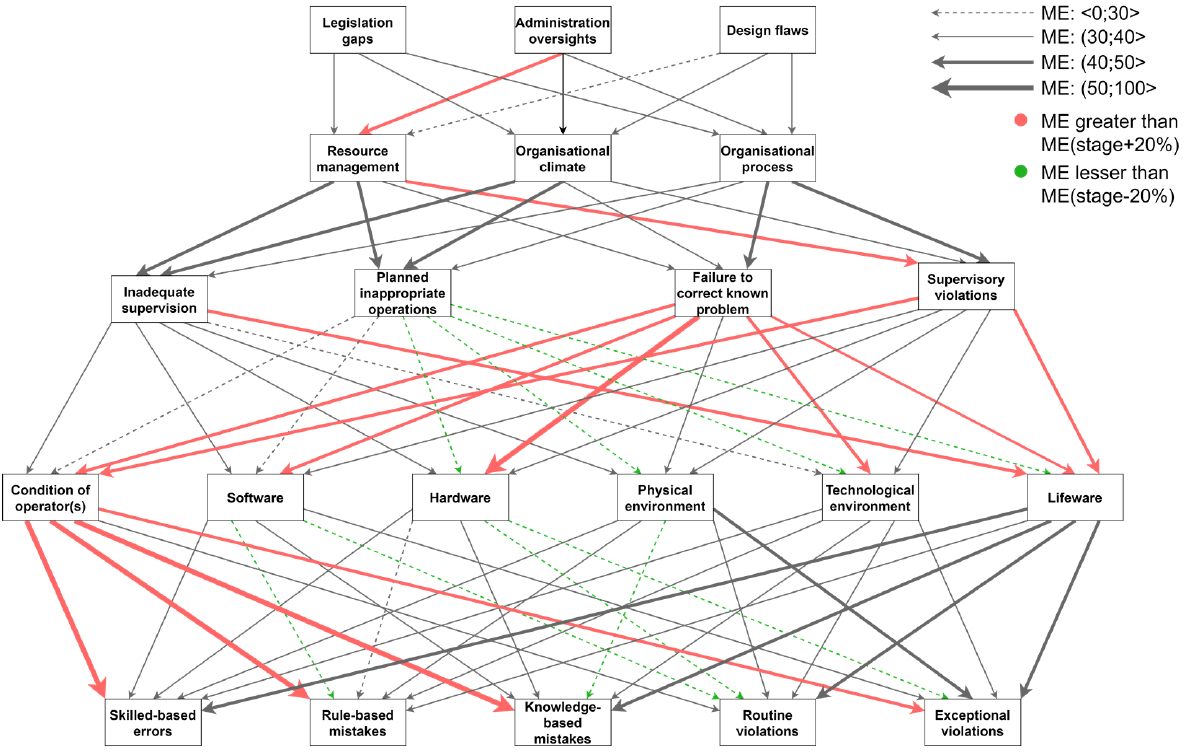
Figure 7. Medians of the influences. The color-coded arrows indicate that a particular influence was assessed as at least 20% stronger/weaker than the median for the stage to which it belongs.